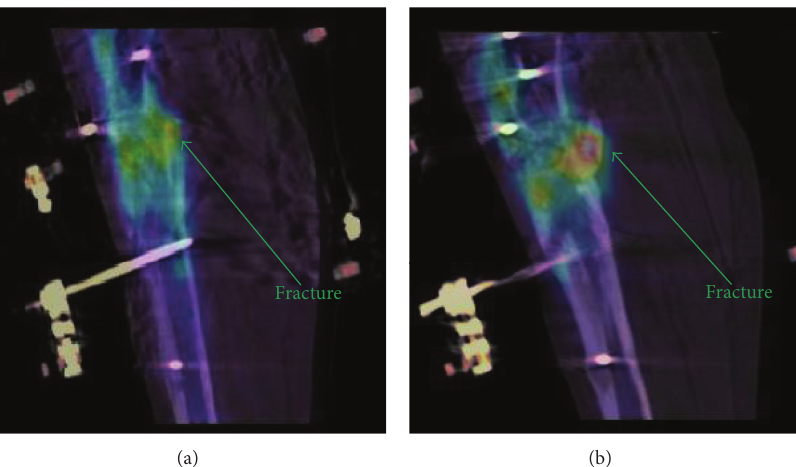
Figure 2: A sagittal fused PET/CT section of the crural remodeling area for Patient 1 at 40 days (a) and at 84 days (b) after the initial operation to attach the TSF. The crural remodeling region on the PET is better aligned to the CT in (a) than in (b). Table 3: Maximum SUV at two different times. The patient (P3) with both legs treated is marked with P3 L (left) and P3 R (right) and the patient with very active bone turnover in the fibula is marked with P4 R (right) and P4 F (fibula). Patient Days TSF surgery Operated leg SUV Nonoperated leg SUV max max 40